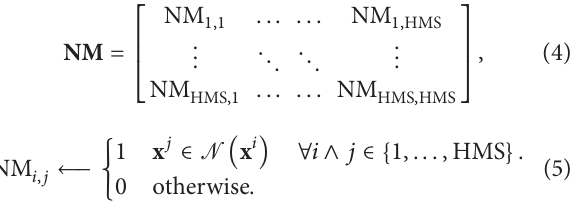
small neighborhood regions in the cellular automata. Par- ticularly, the overlap of the neighborhood provides implicit technique migration into population. Therefore, the best solutions are diffused smoothly in the whole population, where the diversity of the cellular harmony search is pre- served throughout the search. The cellular HS model includes several